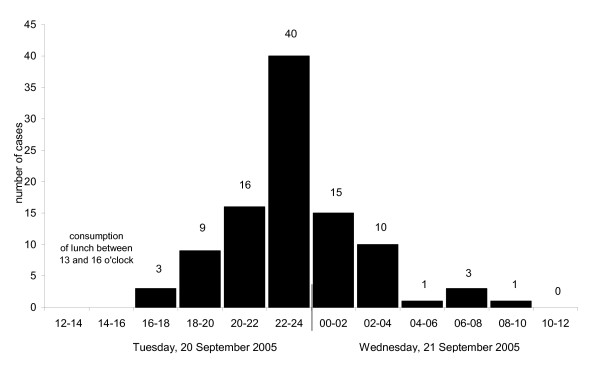
Epidemic curve of cases of acute gastroenteritis in the Air Force Base.